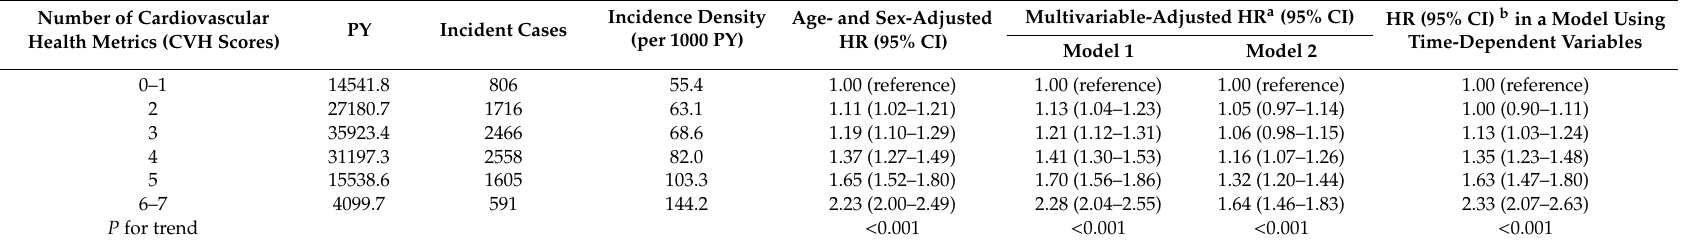
Table 4. Regression of NAFLD by cardiovascular health metrics at baseline among 37,517 participants with NAFLD. Number of Cardiovascular Health Metrics (CVH